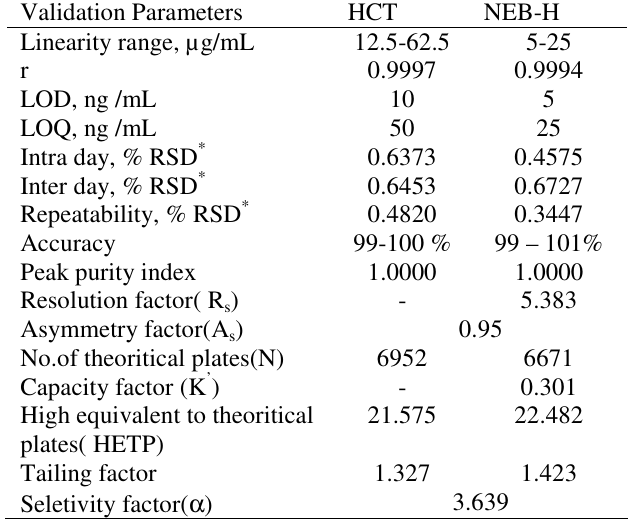
Table 4. System suitability and validation parameters for